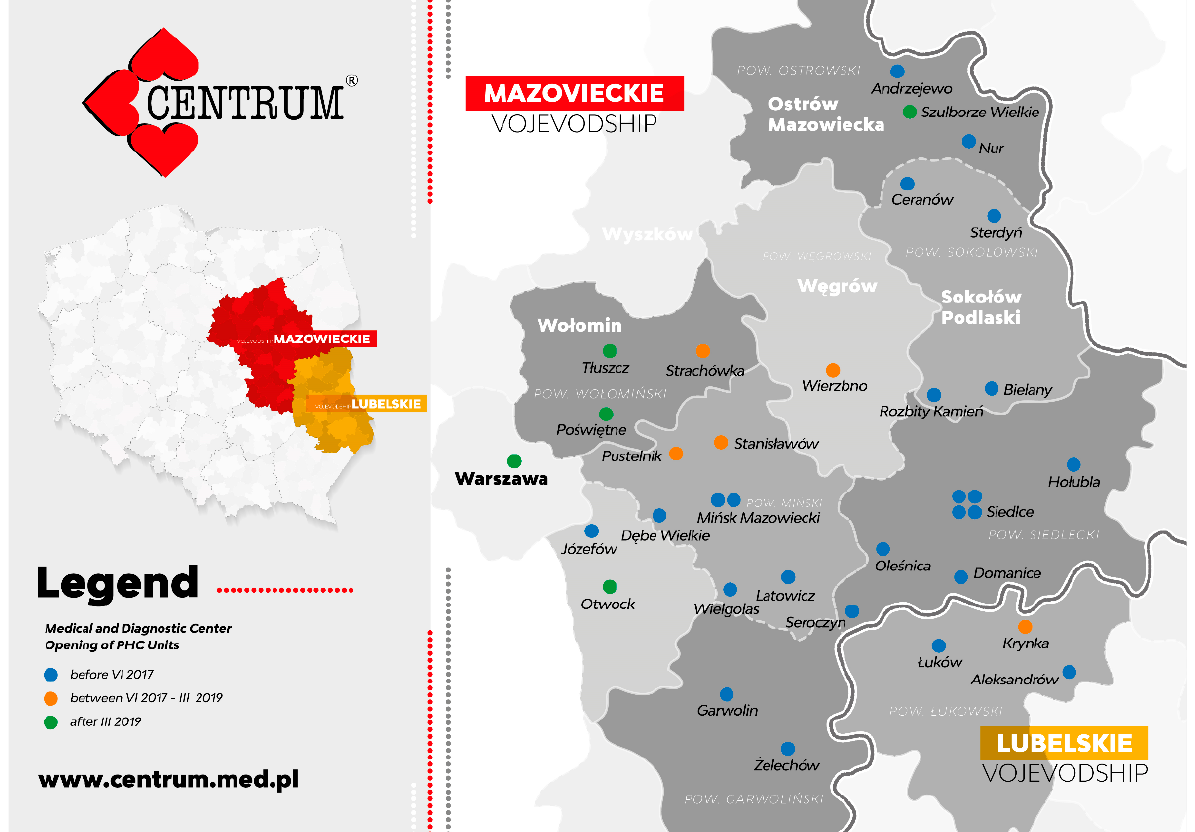
Figure 3. MDC development from June 2017 to June 2019 with the three specified stages